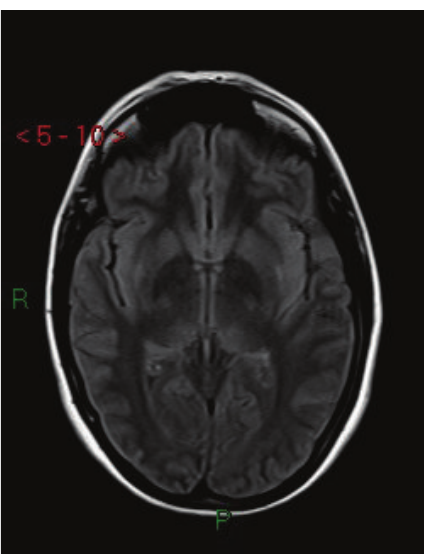
Figure 5: Case 3. Axial T2-FLAIR MRI: cortical-subcortical hyper- intense lesions at the insular cortex and bilaterally at the lateral parts of the putamen.